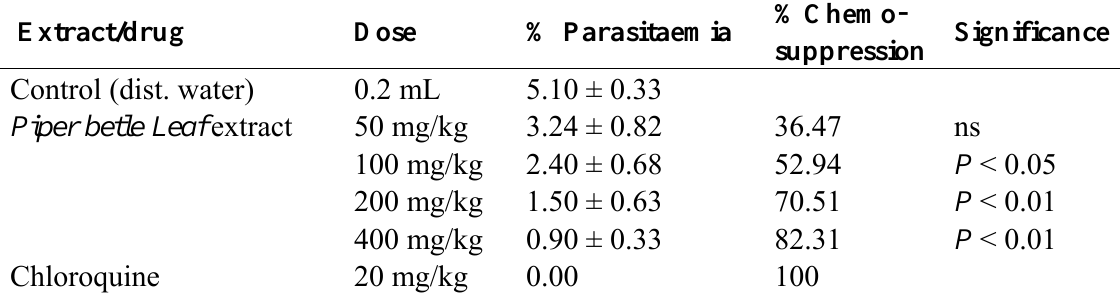
Table 1. Effects of methanol extract of Piper betle on early malaria